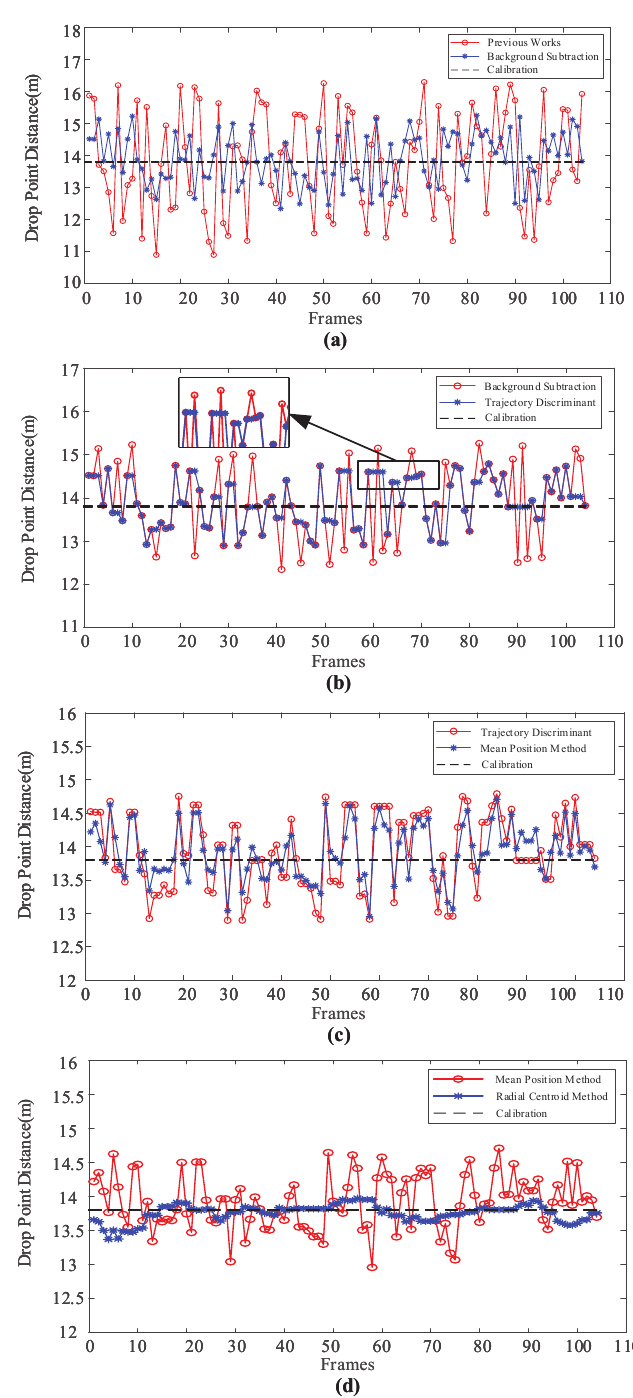
Figure 10. Comparison of jet trajectory falling position prediction results with Mixed Gaussian background subtraction, jet trajectory discrimination, mean position method, and radial centroid method were used incrementally. ( a ) Mixed Gaussian background subtraction; ( b ) jet trajectory discrimination; ( c ) mean position method; ( d ) radial centroid